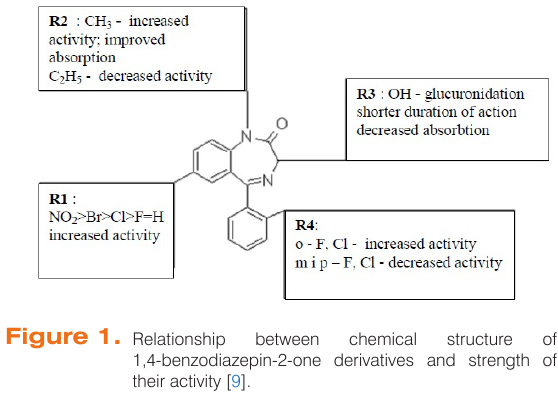
Figure 1. Relationship between chemical